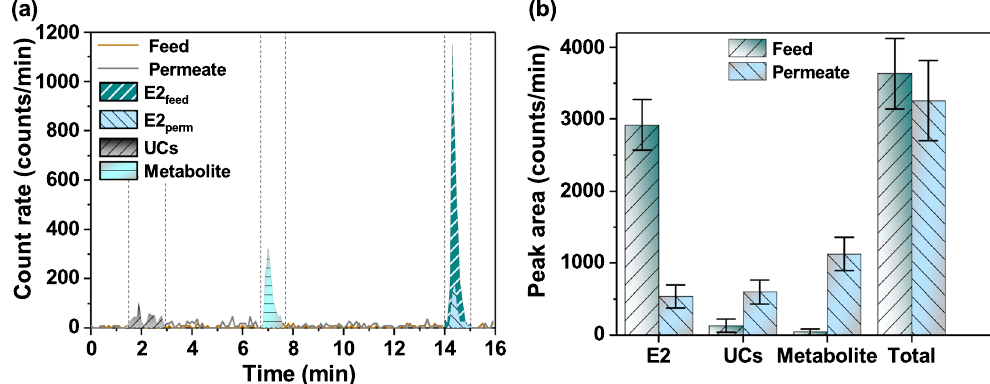
Figure 7. ( a ) The UHPLC-FSA radiochromatograms of feed and permeate solutions of E2 at 100 ng/L. ( b ) The change of peak areas for E2, unretained compounds (UCs), metabolite (new product) and total integrated area ( t r = 0–16 min). The error bar was estimated via the error propagation approach as presented in Supplementary